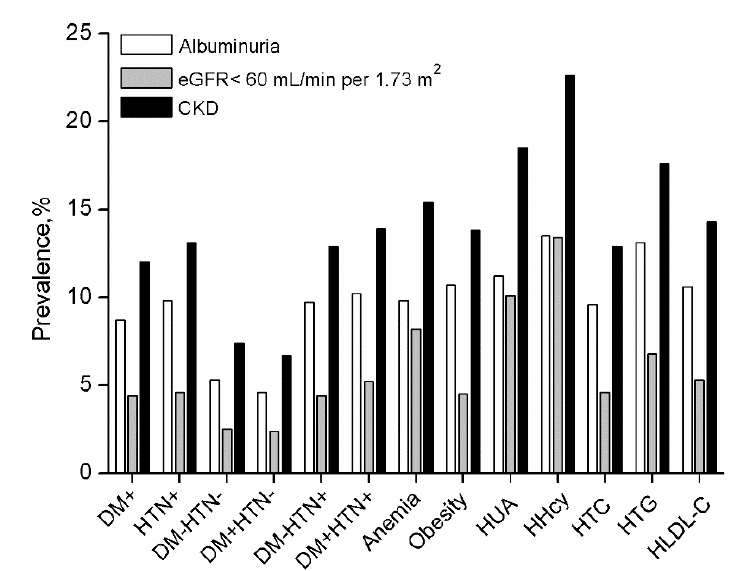
Figure 1. Prevalence of indicators of chronic kidney disease in different comorbidities groups. DM, diabetes; HTN, hypertension; HUA, hyperuricemia; HHcy, hyperhomocysteinemia; HTC, hypercholesteremia; HTG, hypertriglyceridemia; HLDL-C, LDL-C ≥ 4.1 mmol/L. CKD, chronic kidney disease.